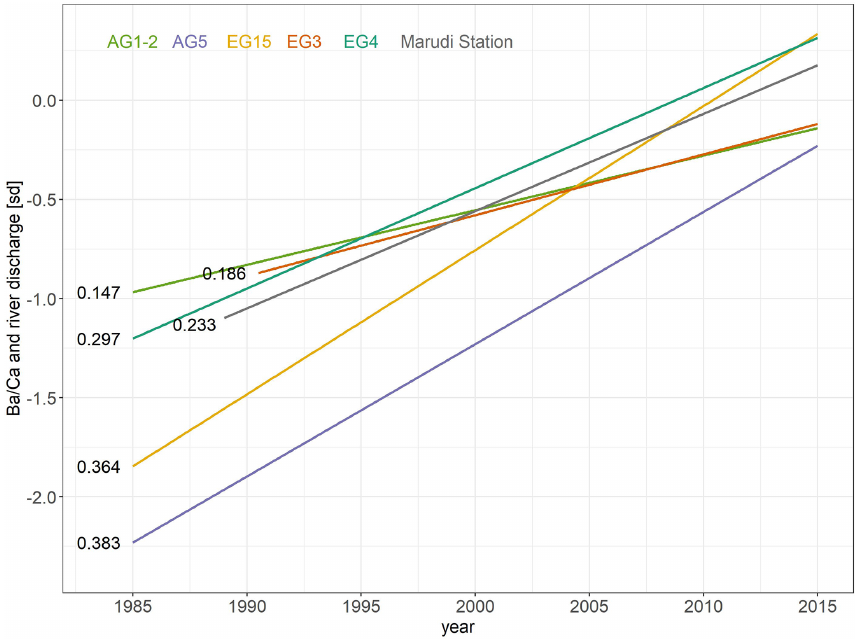
Figure 3. Trends in the Ba / Ca record of all five cores as well as river discharge using Sen’s non-parametric method. The increasing trends are indicated by the Mann–Kendall τ B statistic next to each record; all results are significant at the 95%